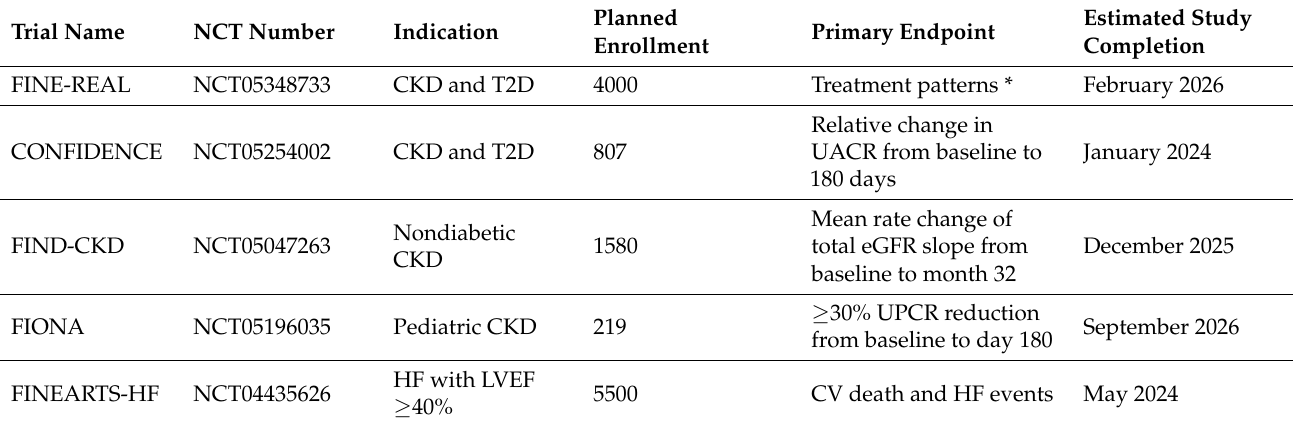
Table 4. Ongoing clinical studies with